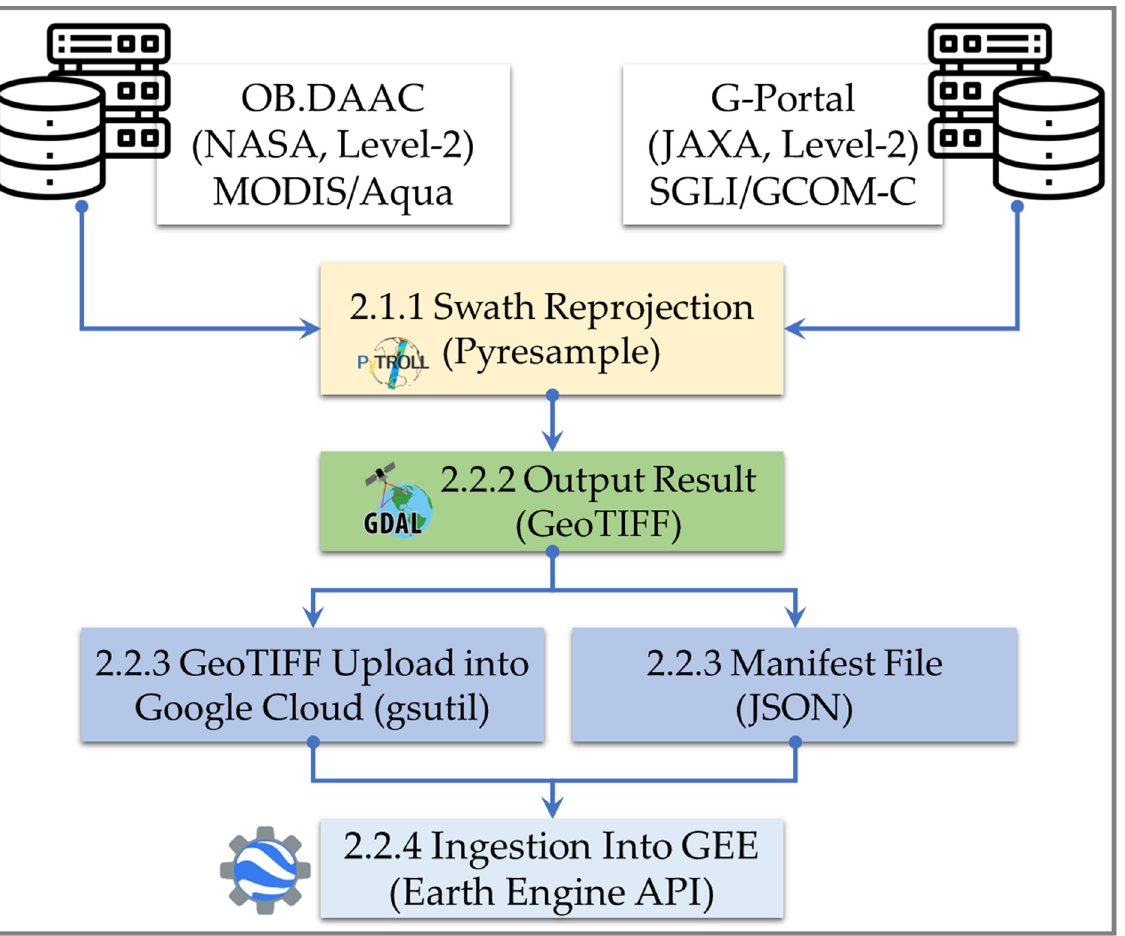
Figure 1. Schematic of the data reprojection and ingestion into GEE. The numbers in the steps correspond to the sub-sections with detailed explanation given in the text.